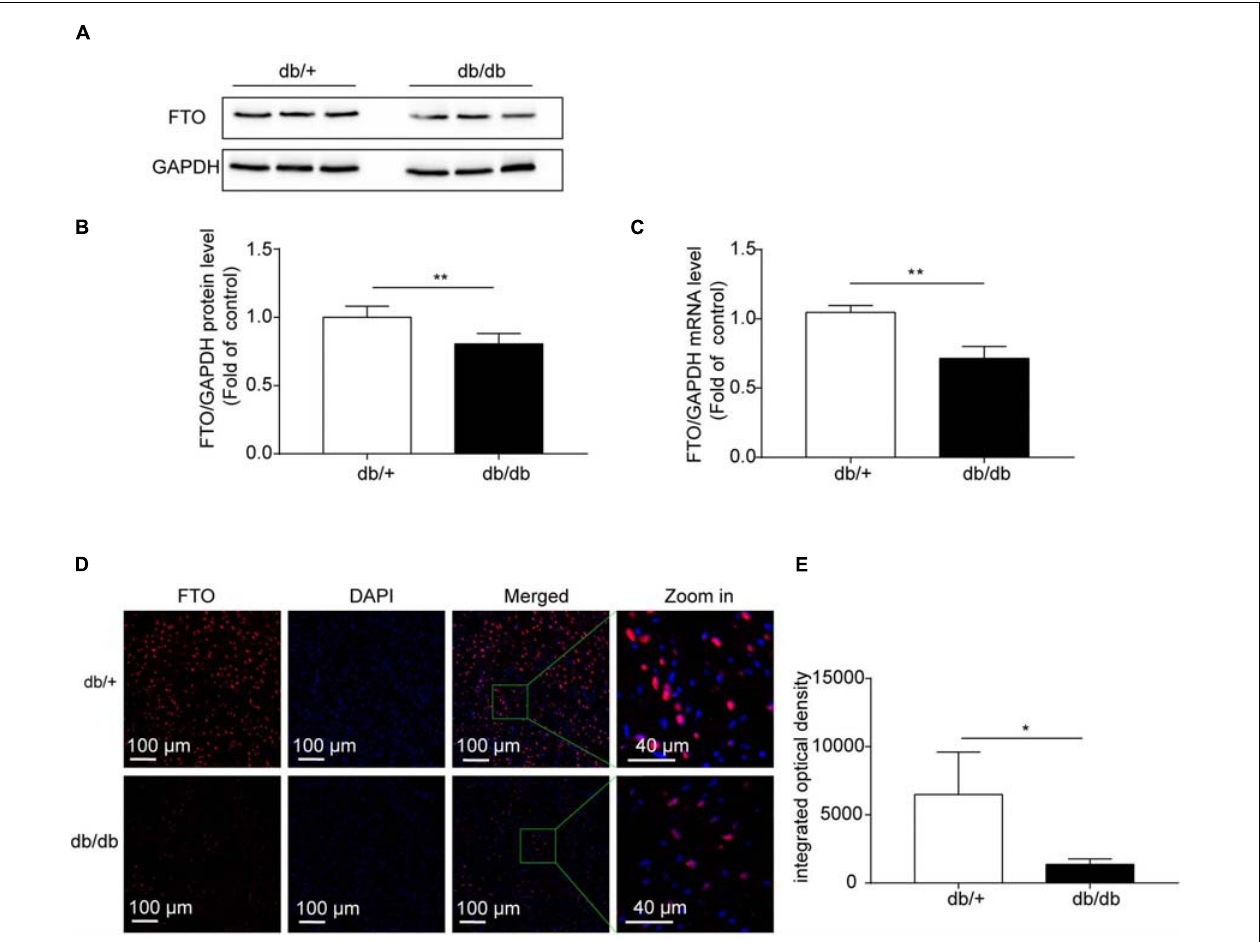
FIGURE 5 | Fat mass and obesity-associated (FTO) protein levels were significantly downregulated in diabetic cardiomyopathy. (A,B) Representative western blots and quantitative analysis of FTO/GAPDH protein expression in hearts from DCM and NC mice ( n = 6 per group). (C) Fto mRNA levels in hearts from DCM and NC mice ( n = 6 per group). (D) Confocal immunofluorescence using specific antibodies against FTO (red) in DCM hearts. Nuclei were stained with DAPI (blue), merged images show co-localization. Scale bar, 100 µ m. (E) Quantification of FTO fluorescence intensity. Data are presented as mean ± SEM; differences between two groups were analyzed using the Student’s t -test; * P < 0.05 vs. NC, ** P < 0.01 vs.